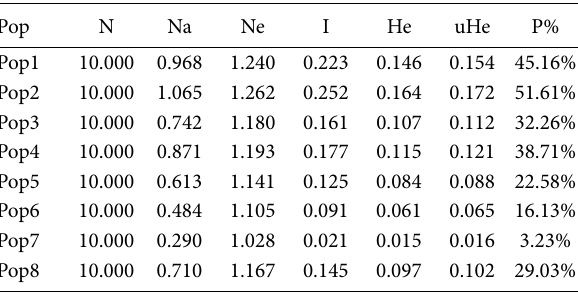
Table 2. Genetic variability parameters determined in Ziziphus jujube populations based on ISSR markers (populations numbers are according to Fig. 1).